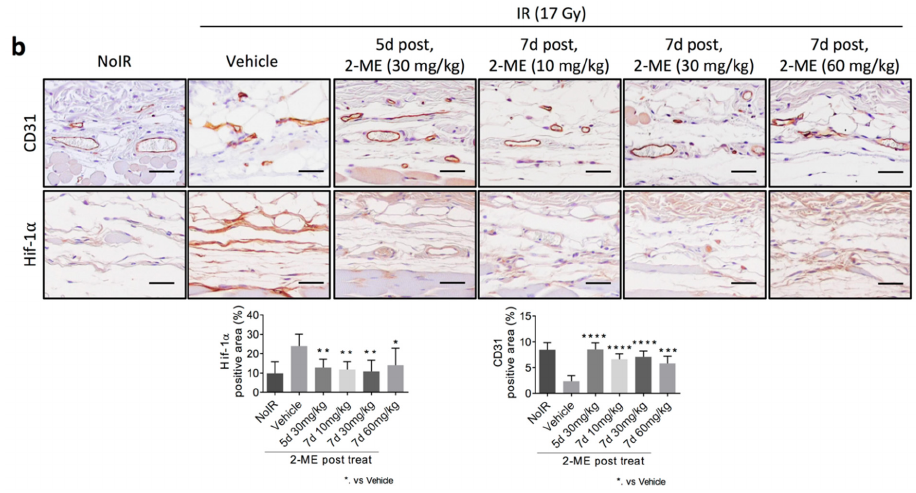
Figure 2. 2-ME treatment repairs vascular injuries 5 or 7 days after irradiation, resulting in decreased skin injuries. C57BL/6 mice skin were irradiated with 17 Gy using a 4-cm field. ( a ) Mice were orally injected with 2-ME (30 mg/kg) 5 days and 7 days after irradiation a total of 6 times in 3 weeks. Representative images of skins vessels, H&E staining, and Masson’s Trichrome staining in skin tissues 3 weeks after irradiation with or without 2-ME. Scale bar = 100 µ m; scale bar of the cropped images = 50 µ m. Quantification of collagen deposition area per field as an average of five fields (magnification, 200 × , n > 3). Scoring of inflammation, fibrosis grades, and collagen deposition are shown. ( b ) Immunohistochemical detection of CD31 and HIF-1 α in skin tissues 3 weeks after irradiation. Scale bar = 50 µ m. Quantification of CD31 + area and HIF-1 α + area per field as an average of five fields (magnification, 200 × , n > 3). For all graphs, error bars indicate the SD from n > 3 biologically independent experiments (one-way ANOVA for multiple comparisons). * p <